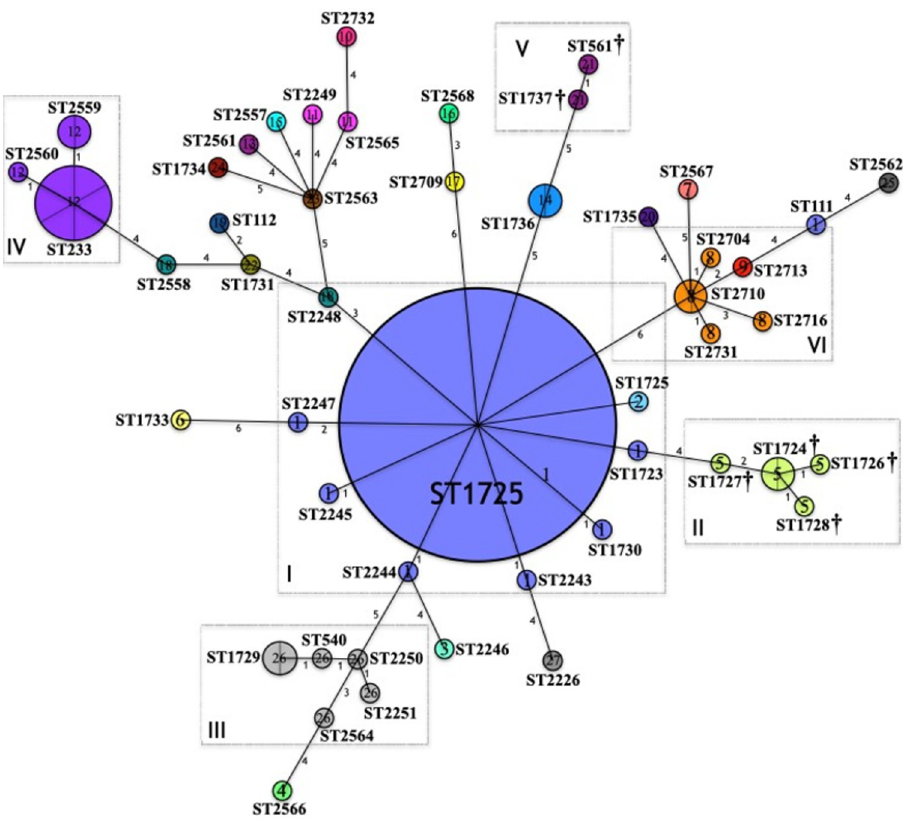
Fig 1. Phylogenetic network based on the MLST genotyping of the P . aeruginosa strains (ST/haplotypes). Phylogenetic relationships, evolutionary history, clonal complexes, and relationship between the mexR-nalC-nalD haplotypes and the STs are shown. P . aeruginosa isolates (n = 91, 48 STs, 27 mexR-nalC-nalD haplotypes). Circles represent sequence types (STs); Circumference is based on ST frequency; Two or more strains with the same ST are depicted as fractions in each circle (ST1725, n = 34 strains); Lines connect locus variants; Numbers indicate the number of locus variants among the connected STs. Clonal complexes (CC) formed are highlighted in rectangles and described as I, II, III, IV, V and, VI. STs not grouped into a CC are considered singletons ( > 3 locus variants with other STs). Numbers inside the circles (1–27) corresponds with the mexR-nalC-nalD haplotype and are colored differently. †: Fatal patient